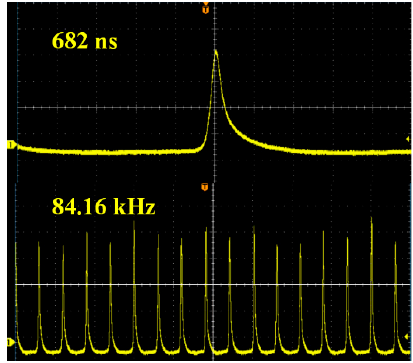
Figure 5. ( a ) The variation of the pulse width and repetition rate, and ( b ) the variation of the pulse energy and peak power.